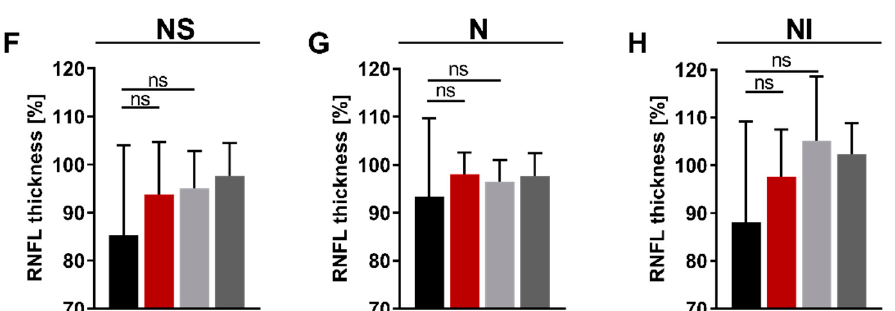
Figure 3. Retinal nerve fiber layer (RNFL) thickness analysis. Optical coherence tomography (OCT) was used to scan the retinal cross-sections in vivo. OCT allowed the acquisition of different retinal layers. For the analysis of the acquired circular B-scans with 12 ◦ diameter, a semi-automatic algorithm was used to define the RNFL and calculate its thickness (RNFLT). The Heidelberg Eye Explorer software divided the scan into the main sectors superior (S), temporal (T), inferior (I), and nasal (N). Furthermore, the sectors temporal superior (TS), temporal inferior (TI), nasal inferior (NI), and nasal superior (NS) were included ( A ). In addition to the regional classification, the schematic illustration also showed the sides of the interventions, episcleral vein occlusion (EVO) and intravitreal injection (IVI), which were performed on the eye during the study (Scheme modified from [22]. The mean RNFLT of the whole B-scan was used for follow-up quantification ( B ). Further quantification of the RNFLT at week 10 was performed for the individual sectors ( C – H ). Legend: black (IgG OS), red (DNM1L), light grey (IgG OD), dark grey (IgG OD), ** p < 0.01, *** p < 0.001, ns = not significant; One-way ANOVA, Tukey’s HSD test (post hoc). Numbers of animals used: n = 7 (IgG), n = 8 DNM1L.